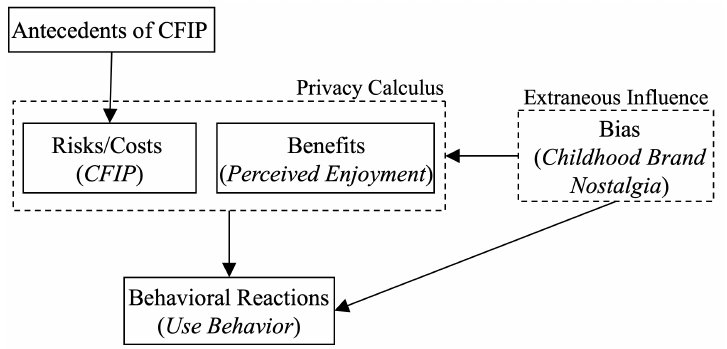
Figure 1. Simplified and adapted representation of the “enhanced APCO” model following Dinev et al.,